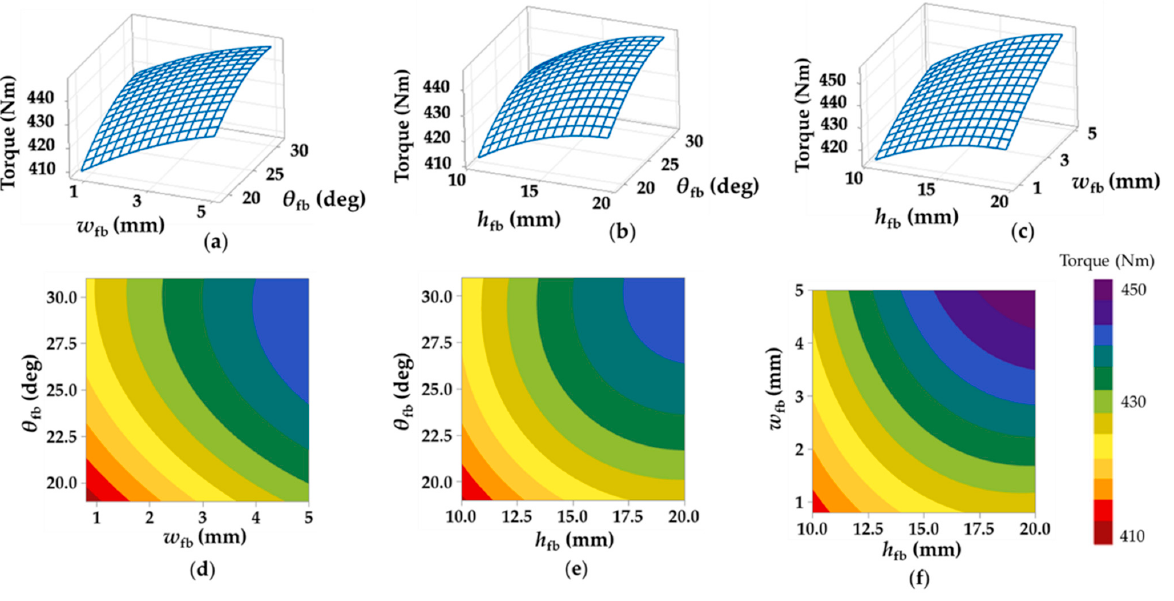
Figure 5. Surfaces and contour plots of average torque resulting from RS methodology of ( a ), ( d ) w fb versus θ fb ; ( b ), ( e ) h fb versus θ fb ; ( c ), ( f ) w fb versus h fb .